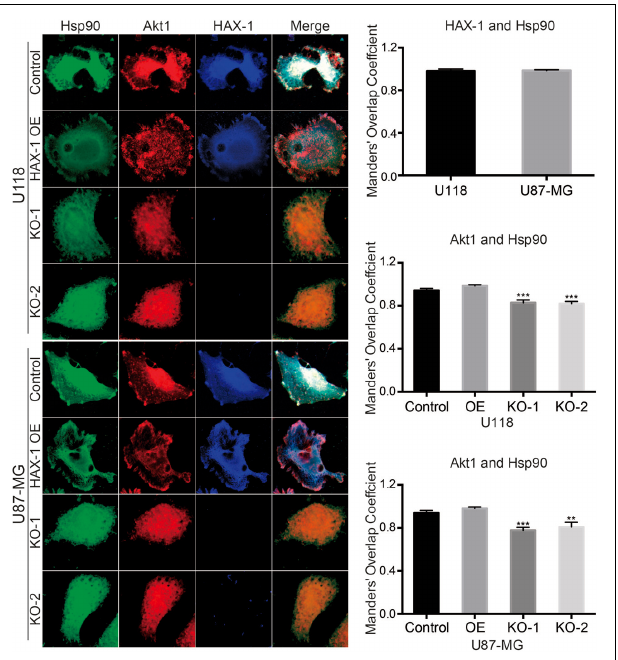
FIGURE 8 | HAX-1 influences the distribution of Akt1 and Hsp90 in U118 and U87-MG cells. Confocal Microscopy showed the co-localization of HAX-1 stained with blue fluorescence, Hsp90 stained with green fluorescence and Akt1 stained with red fluorescence. (original magnification: 600 × ). Manders’ Overlap Coefficient was chosen as the co-location measurement standard. Three individual experiments were performed for each group. ∗∗ P < 0.01, ∗∗∗ P < 0.001.